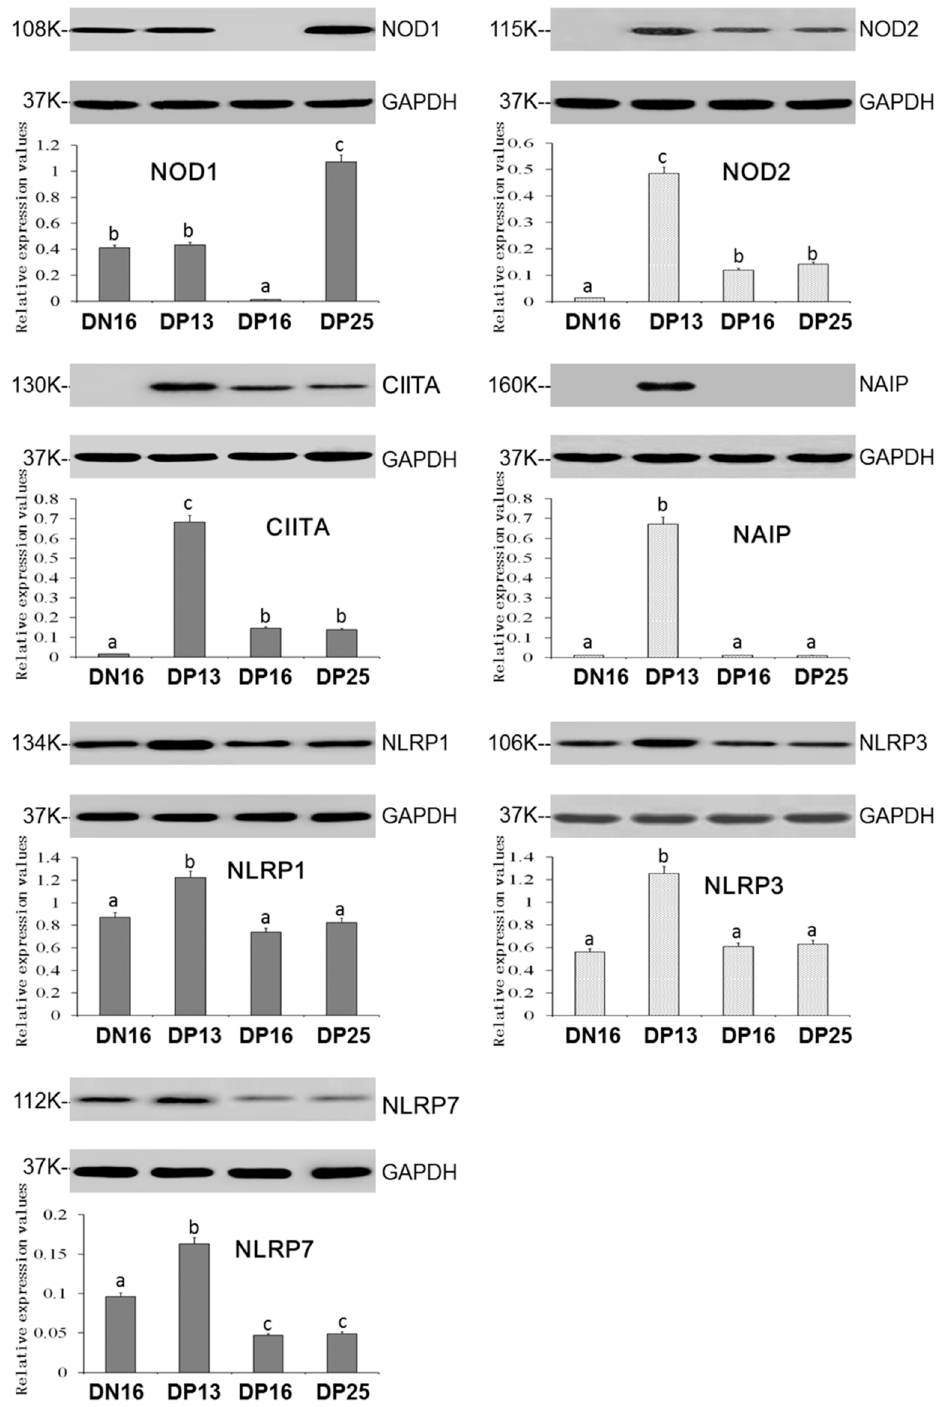
Figure 2. Expression of NOD1, NOD2, CIITA, NAIP, NLRP1, NLRP3 and NLRP7 proteins in the ovine thymus analyzed by Western blot. Note: DN16 = day 16 of the estrous cycle; DP13 = day 13 of pregnancy; DP16 = day 16 of pregnancy; DP25 = day 25 of pregnancy. Significant differences ( p < 0.05) are indicated by different superscript letters within the same color columns.